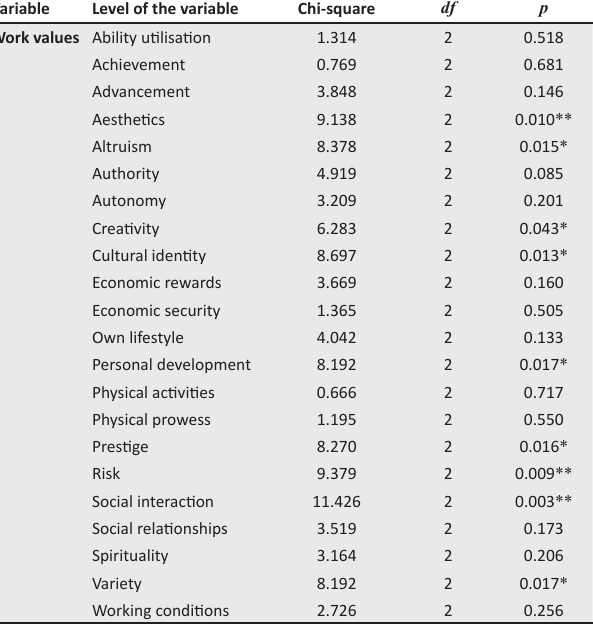
TABLE 4: Kruskal-Wallis test results for work values as dependent variable and generational cohort as independent variable. Variable